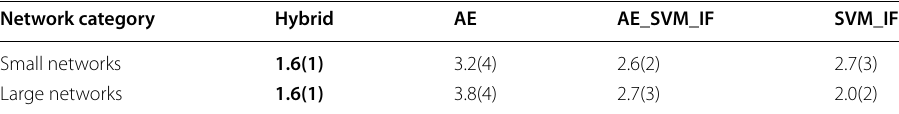
Table 12 Average ranks of NMI scores for AC-SLPA achieved using different cleaning methods on small and large synthetic networks Network category